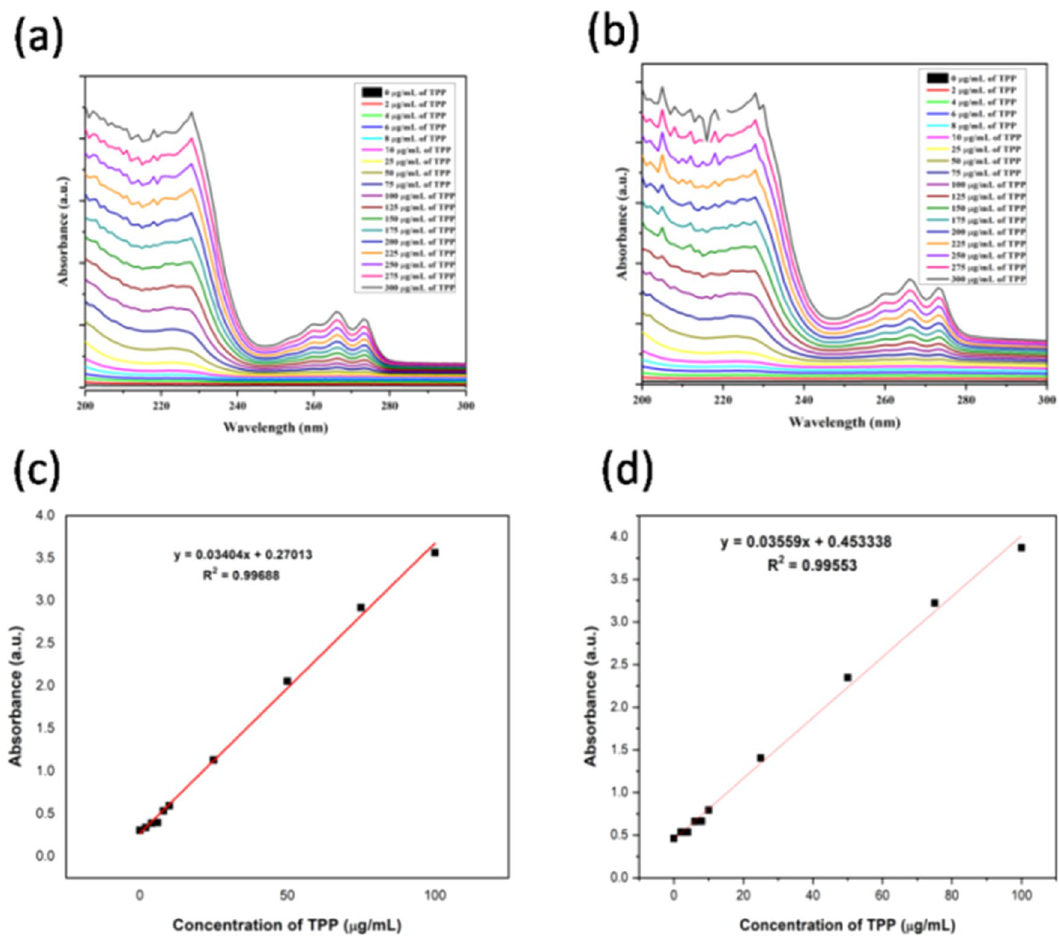
Figure 3. UV– vis absorption spectra of TPP conjugation on the surface of TPP-CTAC©AuNTs ( a ) and TPP- PSS@CTAC©AuNTs ( b ). A linear plot displaying absorbance of TPP measured at 229 nm upon conjugation with CTAC©AuNTs ( c ) and PSS@CTAC©AuNTs ( d